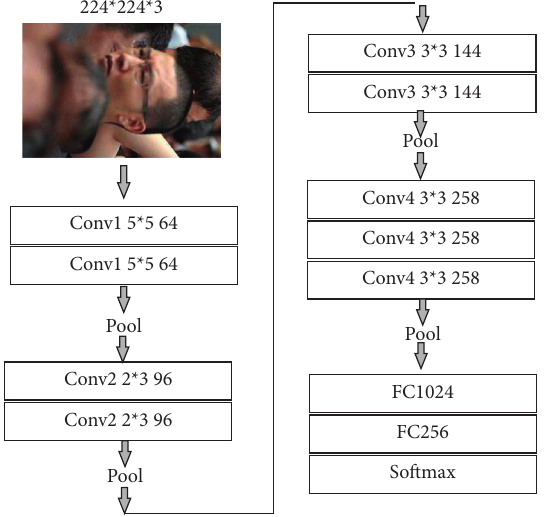
Figure 2: Improved VGG16 network.